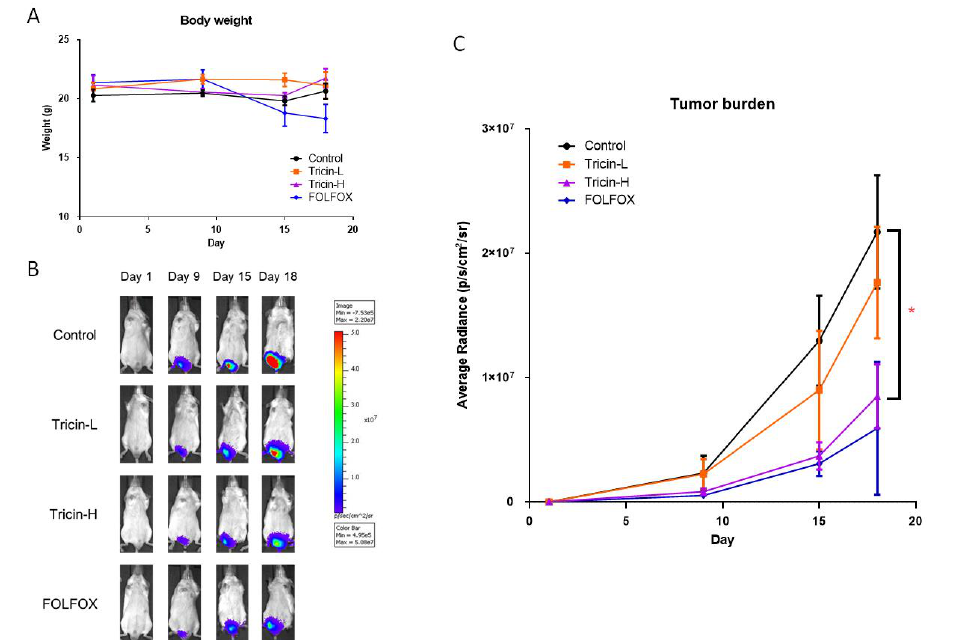
Figure 3. Effects of tricin and FOLFOX on tumor burden in orthotopic colon tumor-bearing mice. Mice were treated with Tricin-L (19 mg/kg), Tricin-H (37.5 mg/kg) or FOLFOX (combination please refer to Methods section) for 18 days. ( A ) Body weights of mice were recorded during the treatment.